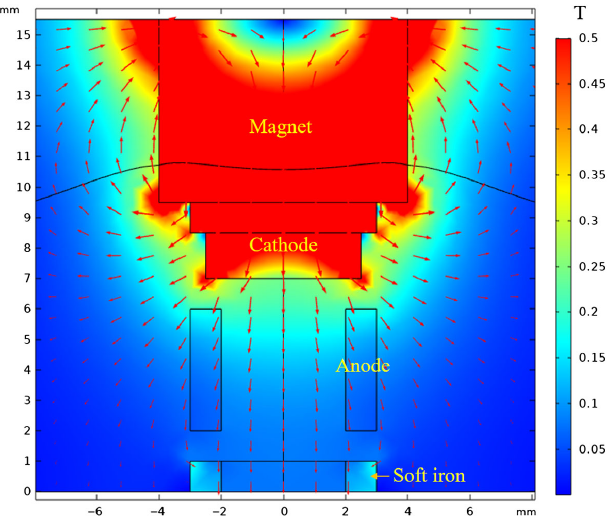
FIG. 3. The optimized magnetic field simulation result of the Penning ion source. Surface: magnetic flux density norm (T), contour: magnetic scalar potential (A), arrow surface: magnetic flux